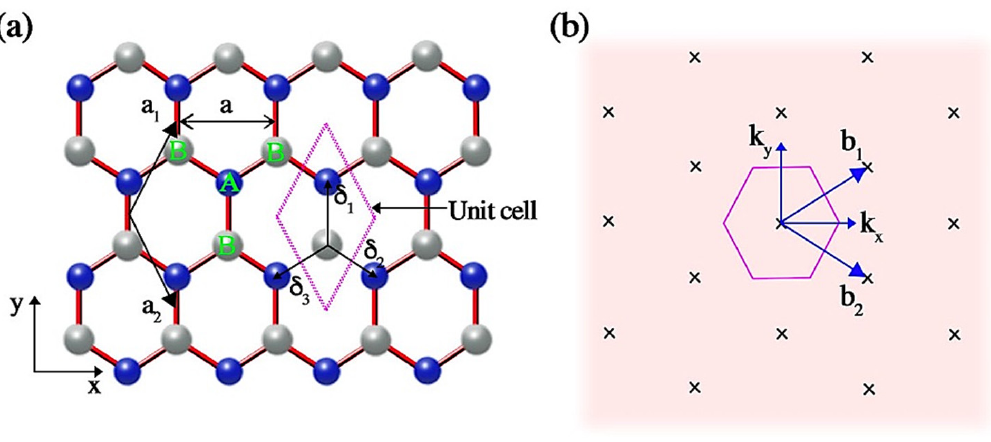
Figure 2. The honeycomb lattice of single-layer graphene, where gray and blue circles represent carbon atoms on ( a ) (B) sites and ( b ) the reciprocal lattice of single o layer graphene, where the shaded hexagon in light pink is the subsequent Brillouin zone.